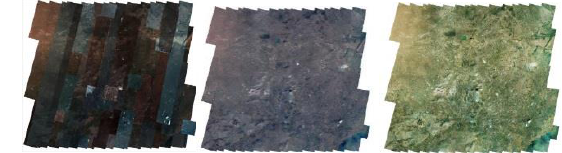
Figure 2 Mosaic uniform color process of K50